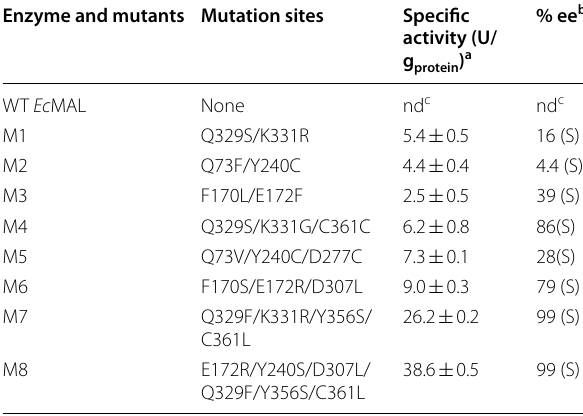
Table 2 Properties of the Ec MAL